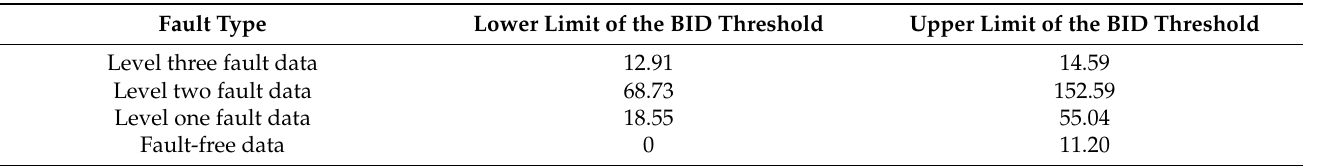
Table 5. BID thresholds of the battery pack.